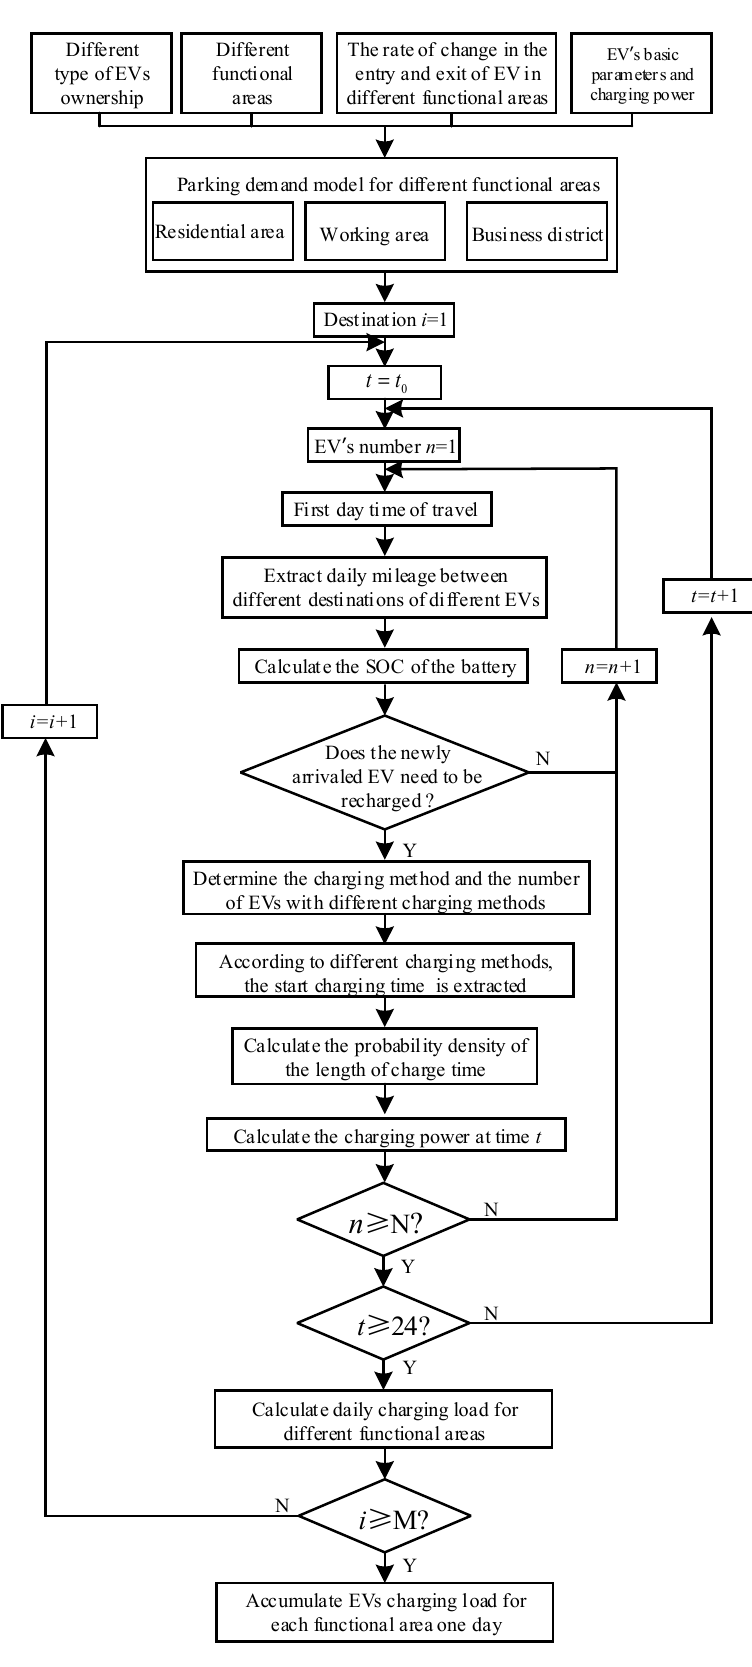
Figure 4. Electric vehicle charging load forecasting flow chart.